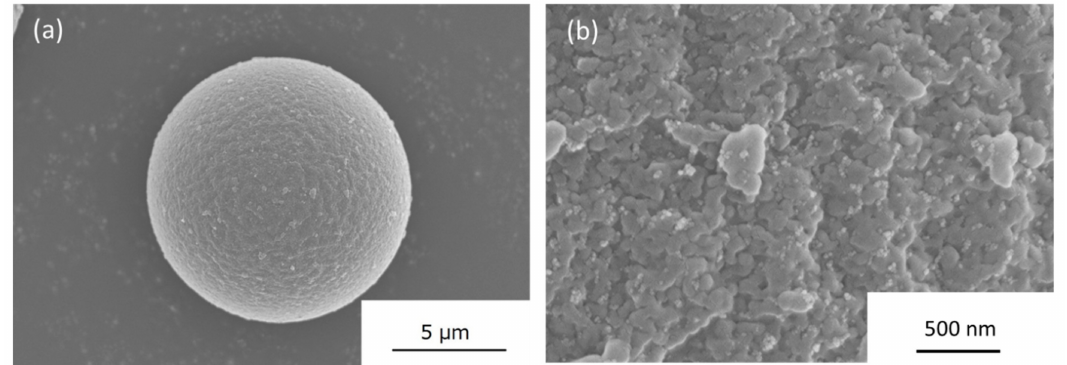
Figure 4. SEM images of the PMMA-ITO composite obtained after electrostatic assembly adsorption of ITO nanoparticles that were surface-modified using pH adjustment in ( a ) low magnification and ( b ) high magnification